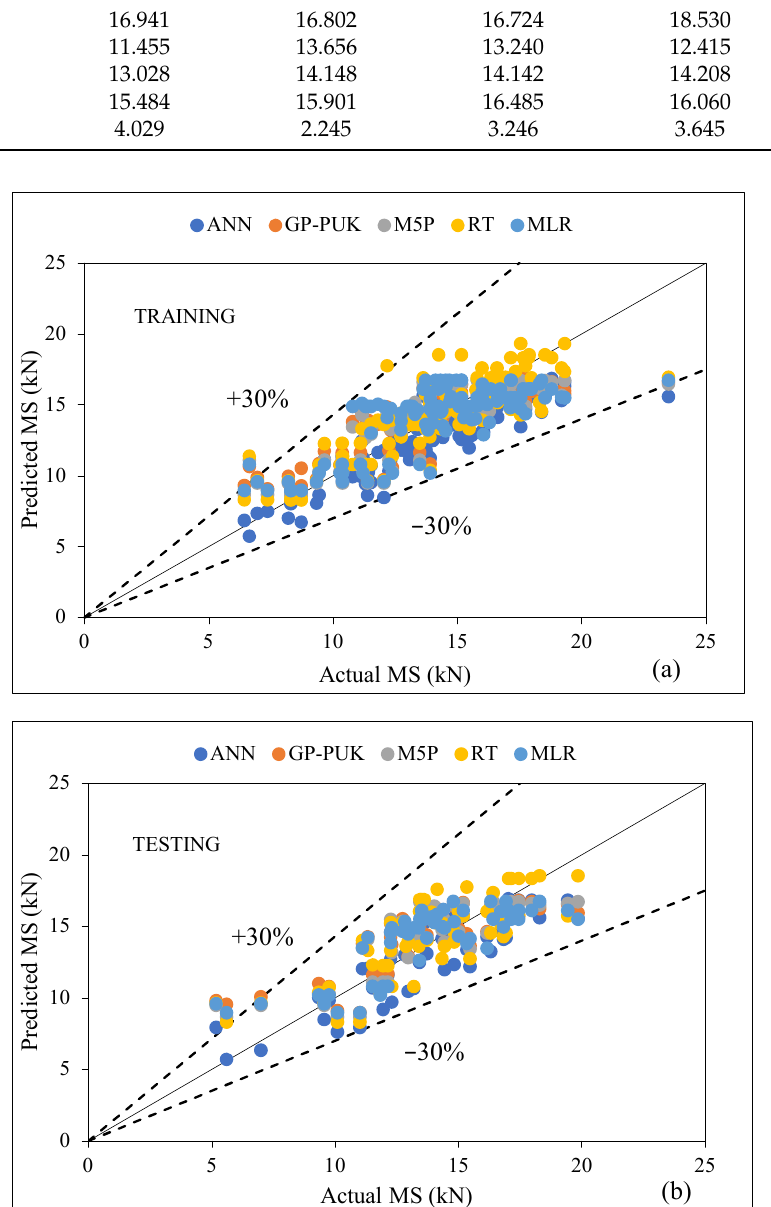
Figure 10. ( a , b ) Comparison of all models using training and testing stages.